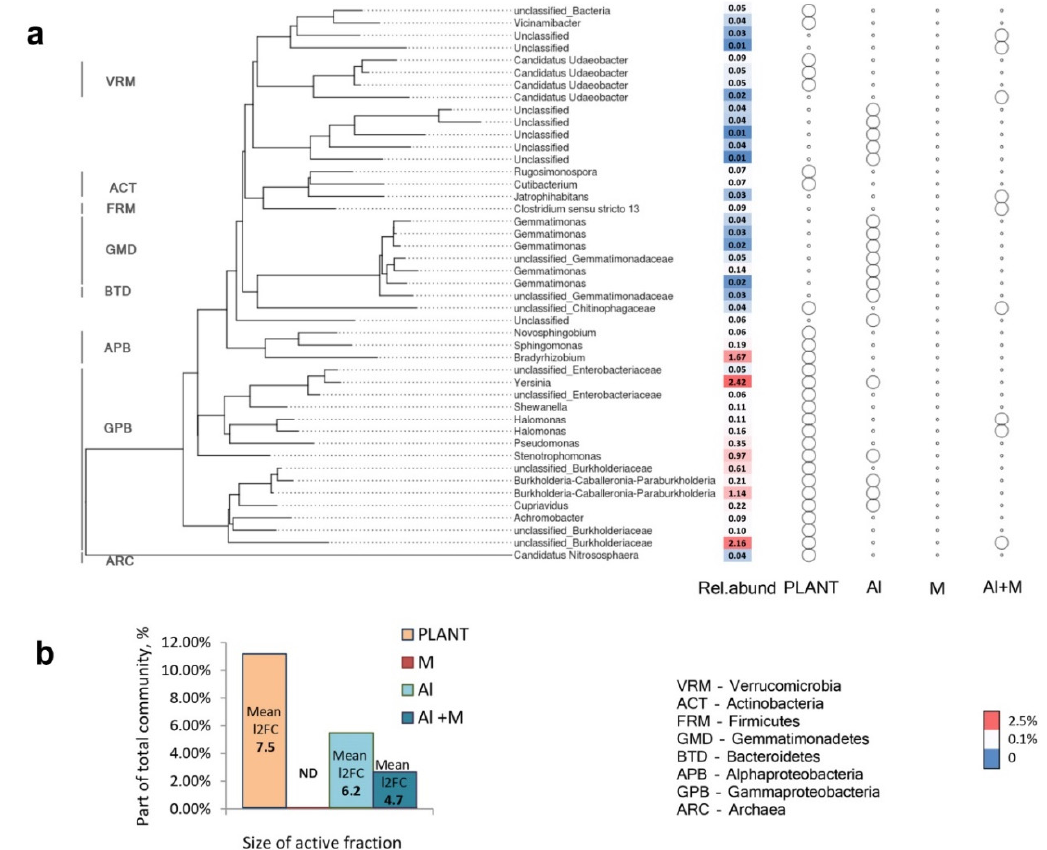
Figure 9. Beta-diversity plots evaluated by Unweighted ( a ) and Weighted ( b ) UniFrac for the rhizosphere prokaryotic microbiomes of pea genotypes VIR1903, VIR7307, VIR8353 and VIR8473 inoculated with microbial consortium. The parenthesized values are percent of variation described by each of axis. See details in the legend to Figure 1.